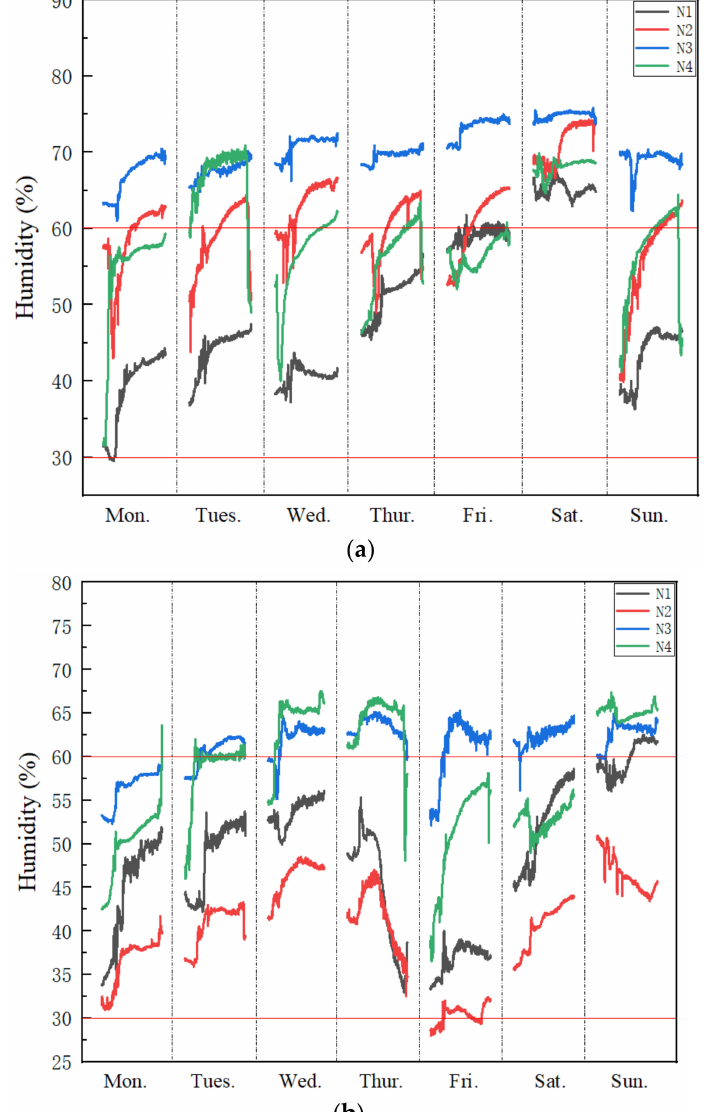
Figure 6. Humidity measurement results. ( a ) Before heating, ( b ) After heating.